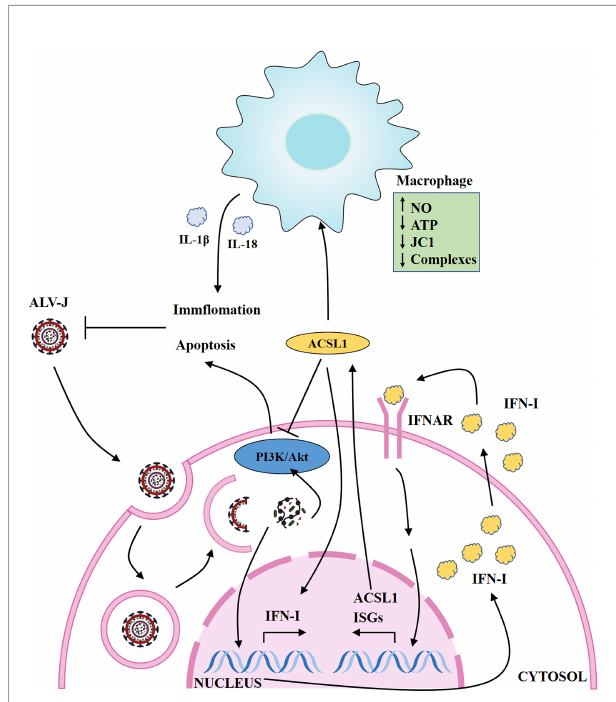
FIGURE 7 | Schematic map of ACSL1 regulating ALV-J replication. ACSL1 positively regulates type IFN-I production, induces apoptosis via the PI3K/Akt signaling pathway, and promotes in fl ammation, which in turn inhibits ALV-J replication. IFNAR, interferon receptors; ISGs, interferon stimulate